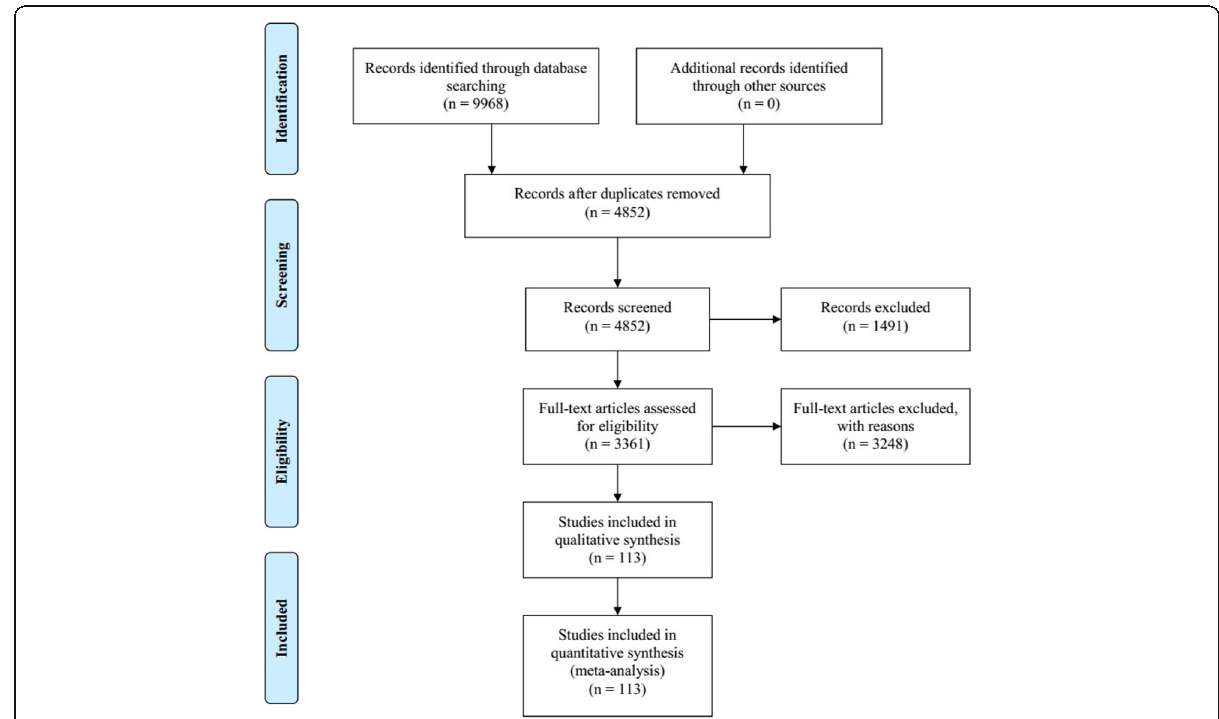
Fig. 1 Flow chart of the search for eligible